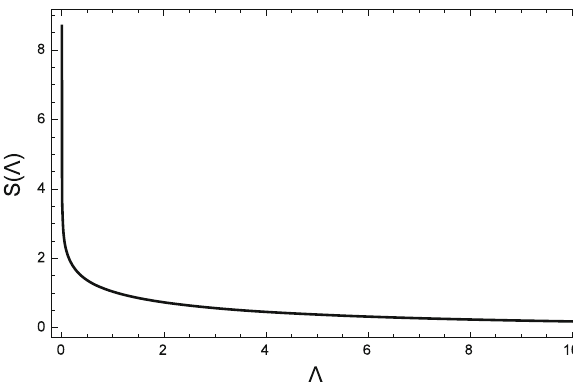
Fig. 3 The entropy of entanglement S (ρ k ) against the cosmological constant Λ . The quantity S (ρ k ) is a monotonically decreasing function of the cosmological constant Λ and it reaches infinity for Λ = 0 while goes to zero as Λ